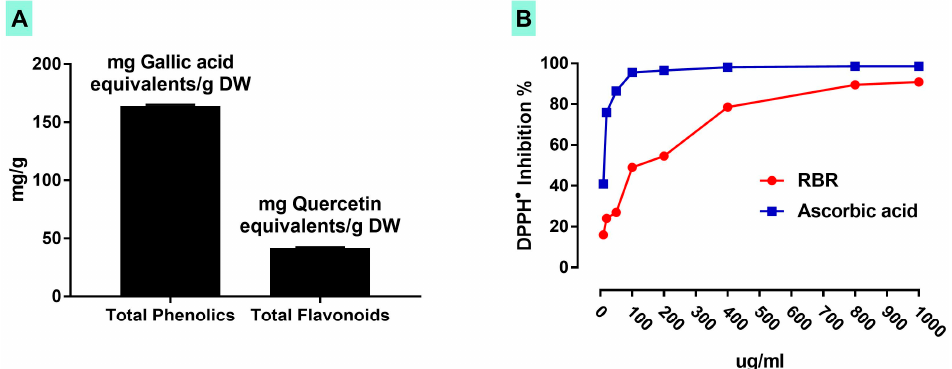
Figure 2. Total phenolics and flavonoids content ( A ) and DPPH • scavenging activity of red beetroot (RBR) extract ( B ). Data are the mean values of triplicate and expressed as mean ± SD.